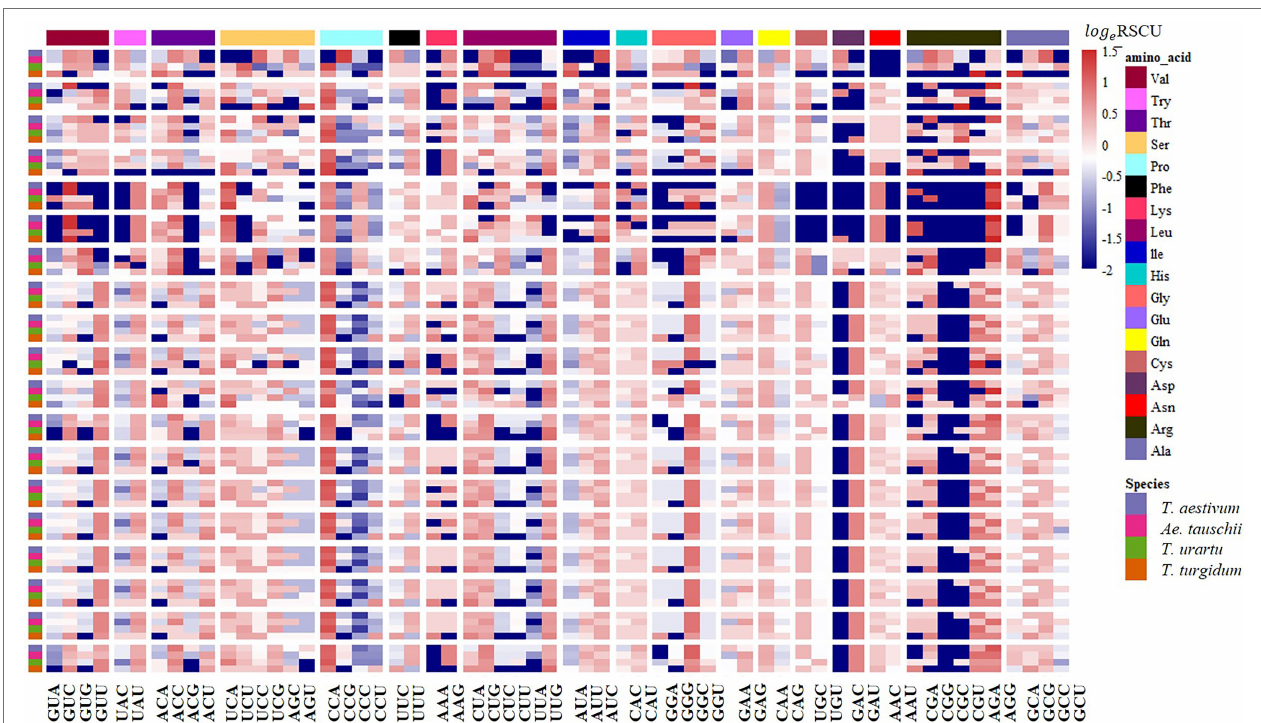
FIGURE 9 | RSCU analysis showing synonymous codon usage preference of the Prolamin gene families in common wheat and its ancestor species. Columns correspond to the 59 nondegenerate, non-stop codons. Rows correspond to special family genes in the four species. Blue cells indicate low bias codons and red cells indicate high bias